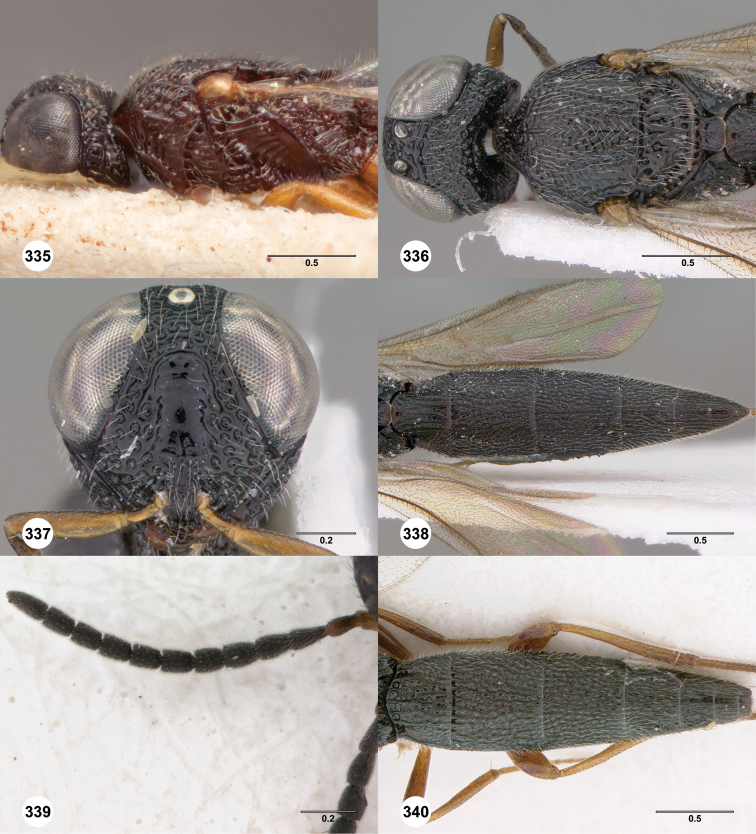
Oxyscelio solitarius (Dodd), female (OSUC 368084) 335 Head and mesosoma, lateral view 336 Head and mesosoma, dorsal view 337 Head, anterior view 338 Metasoma, dorsal view. Paratype male (OSUC 368104) 339 Antenna 340 Metasoma, dorsal view. Morphbank91